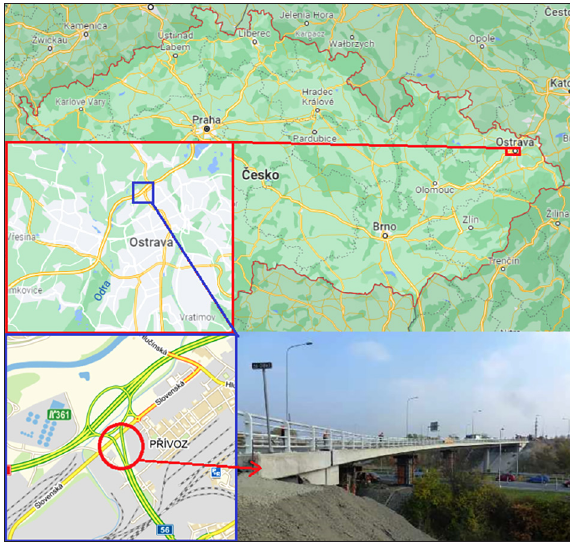
Figure 2. Locality